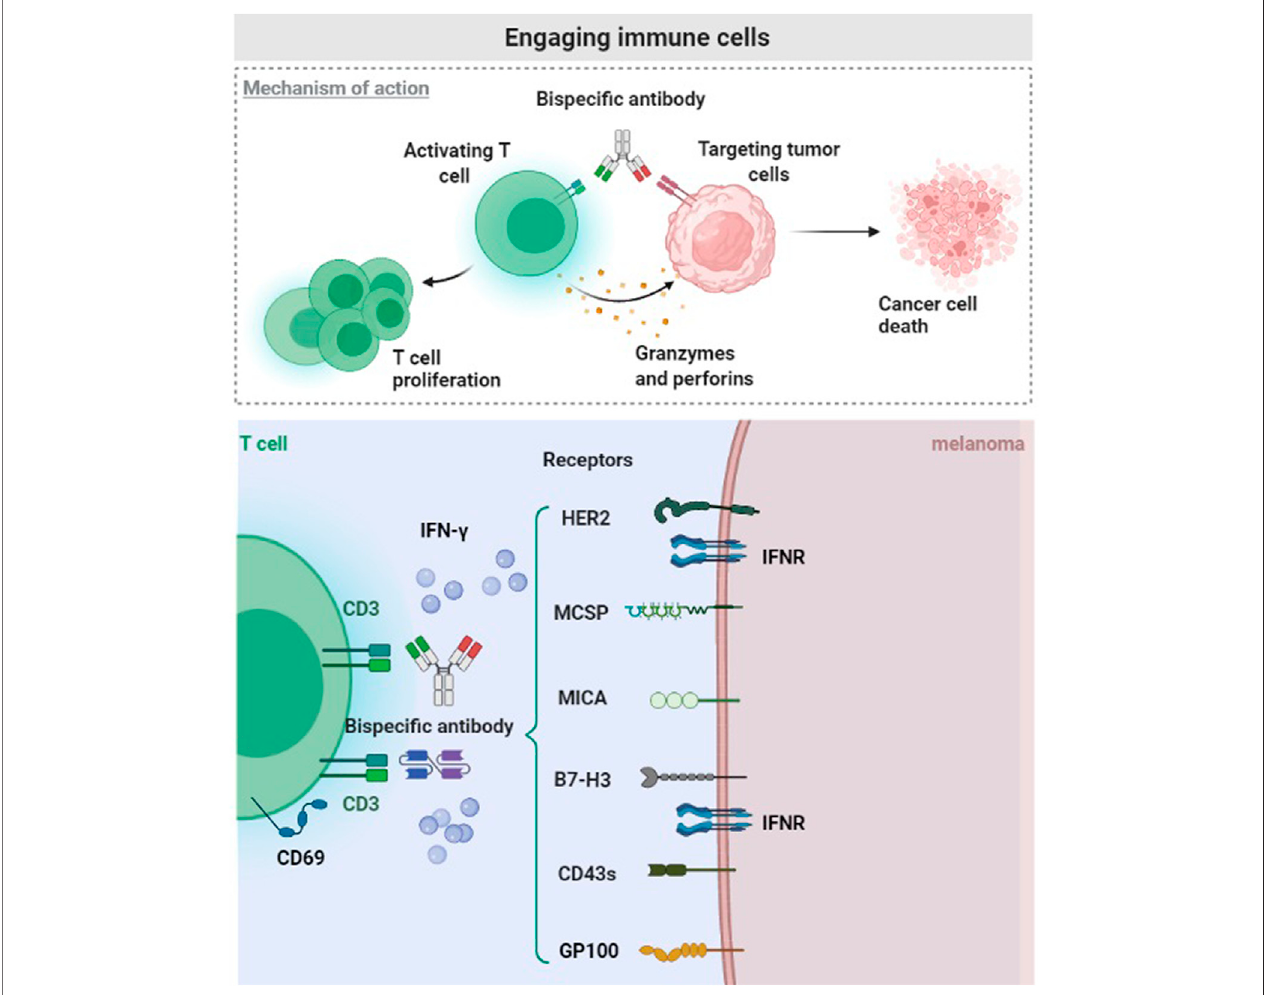
FIGURE 3 | Engaging immune cells. The malignant melanoma microenvironment hinders the transport, in fi ltration and activation of T cells. CD3 related Bispeci fi c antibodies bind tumor-speci fi c antigen (HER2, MCSP, MICA, B7-H3, CD43s, and Glycoprotein 100), potentially promoting the intratumoral in fi ltration and response of T